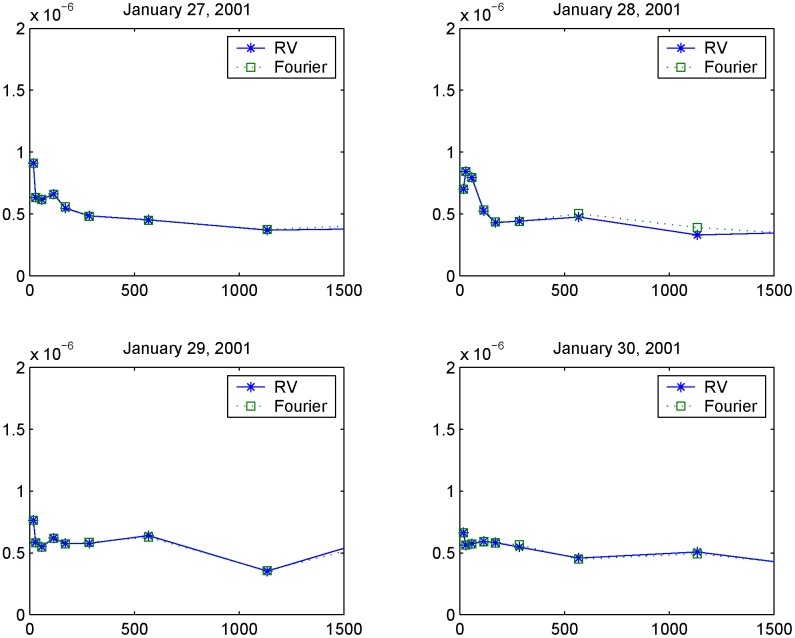
Volatility signature plots versus sampling frequency in seconds.The graphs show the signature plots of liquid market data on January 27-30, 2001